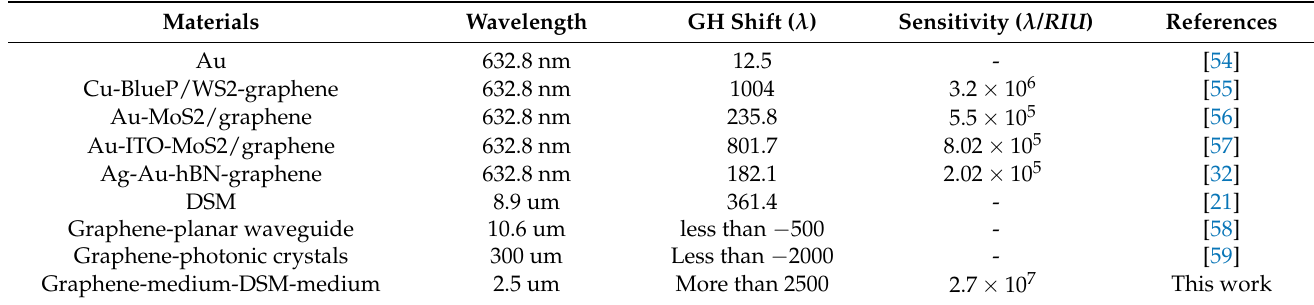
Table 1. Comparison with the different materials SPR